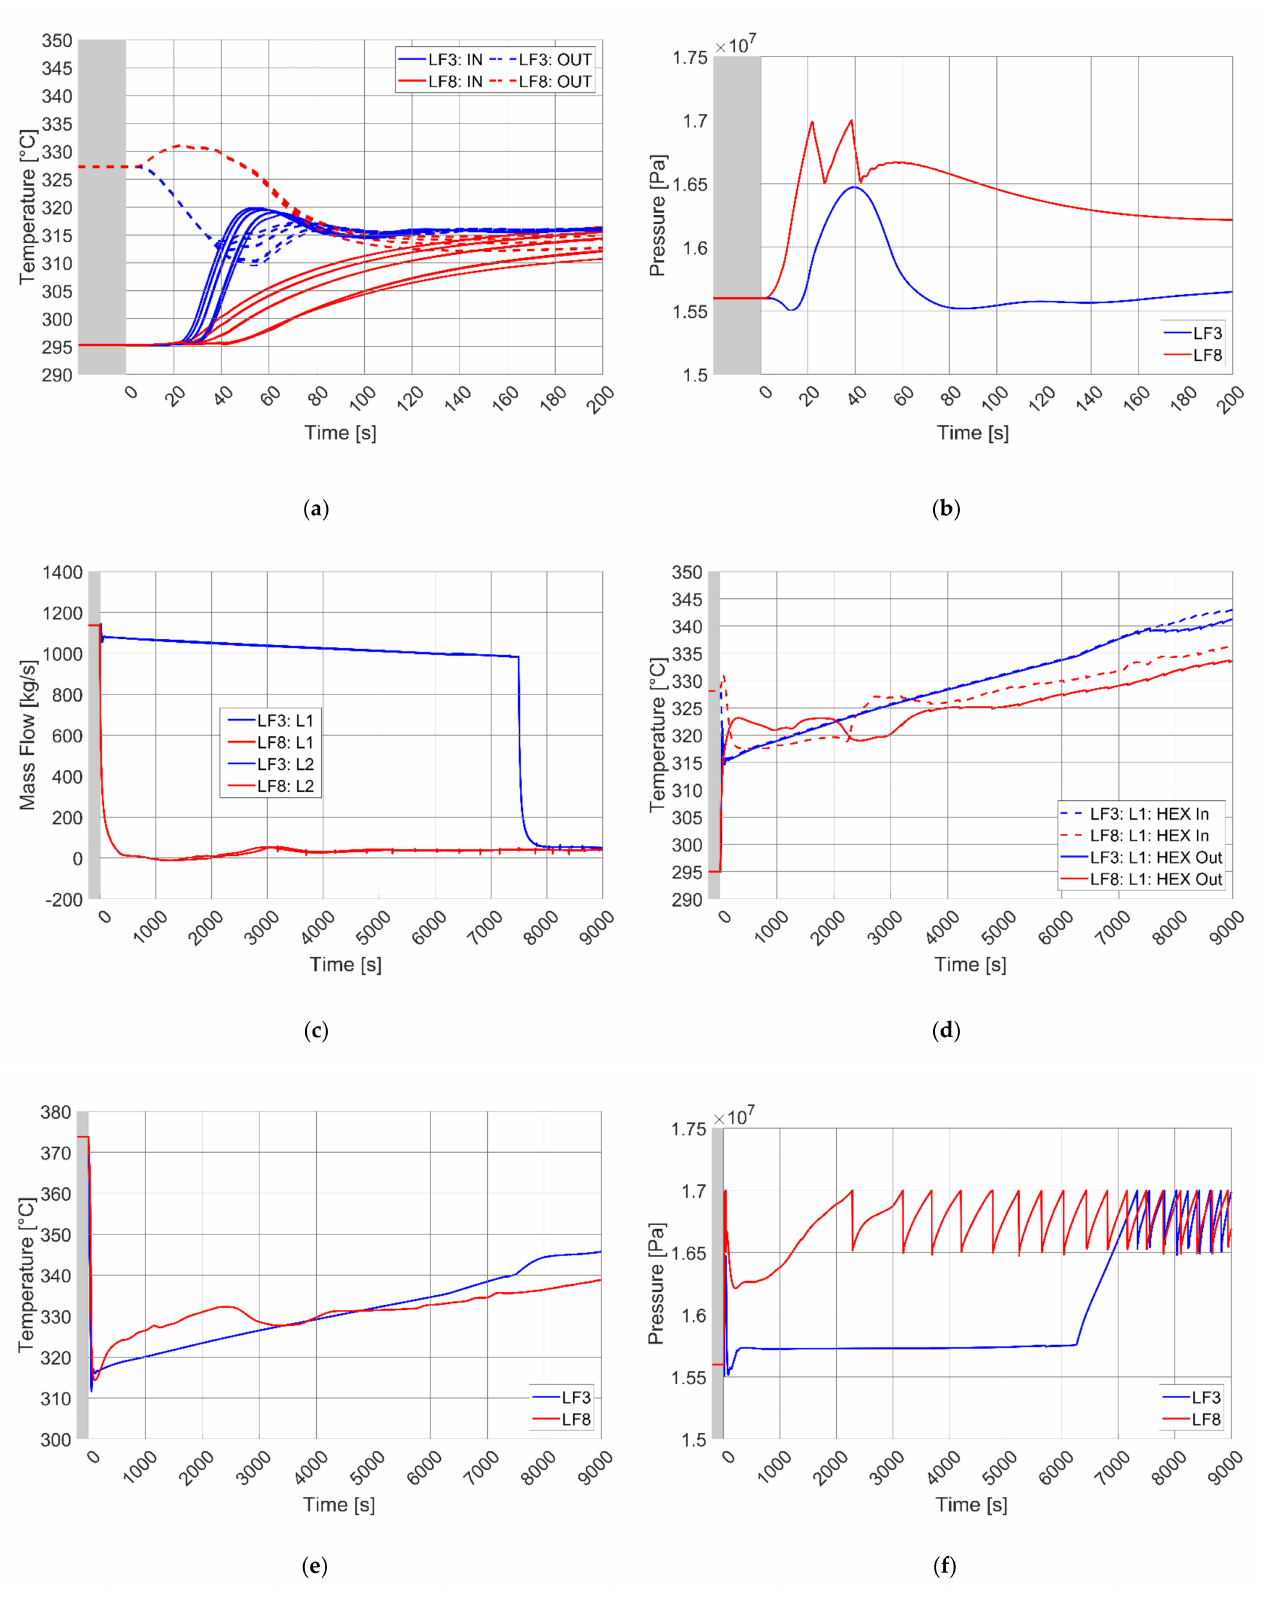
Figure 13. Comparison between LF3 and LF8 transients: ( a ) FW PHTS water temperatures at BB inlet & outlet (all sectors, early time, COB segment); ( b ) Pressure in FW PHTS (early time); ( c ) Mass flow elaborated by FW MCPs (full range); ( d ) FW PHTS water temperatures at HEX inlet & outlet (loop 1, full range); ( e ) Maximum Eurofer temperature in FW component (full range); ( f ) Pressure in FW PHTS (full